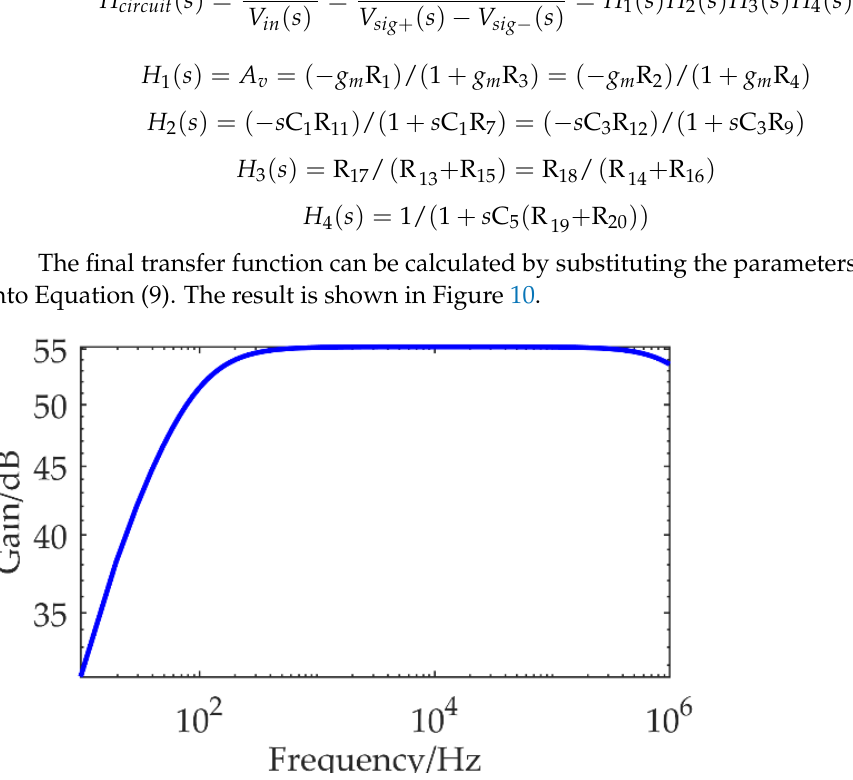
Figure 10. Overall amplitude-frequency characteristic curve of low-noise amplifier